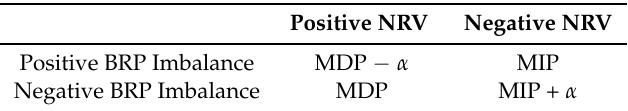
Table 1. Imbalance tariff depending on system shortage/excess. NRV, net regulating volume;